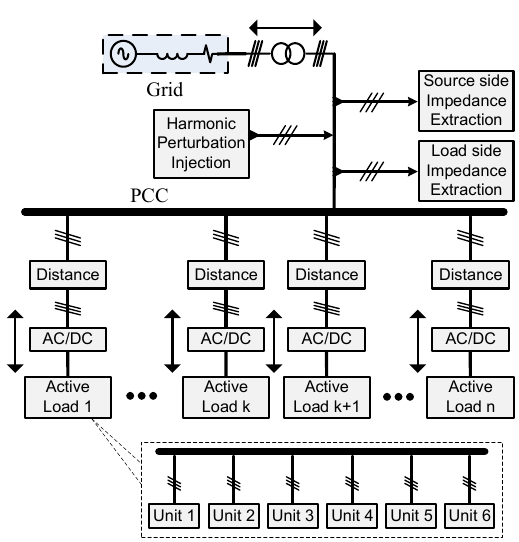
Figure 2. Comparative stability analysis of grid-connected active loads at the point of common coupling (PCC) with changing size, distance, and penetration.